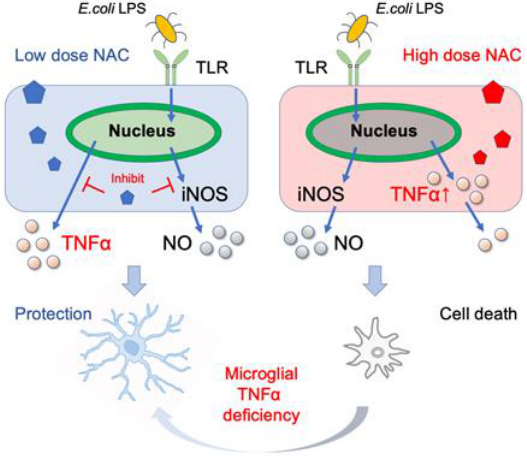
Figure 6. Beneficial and lethal effects of NAC on microglia. The low dose of NAC suppresses the production of E. coli LPS-induced TNF- α and NO production (left), whereas high-dose NAC and E. coli LPS induce aggregation of cellular TNF- α . Furthermore, microglial TNF- α deficiency alleviates high-dose NAC-induced cell death.